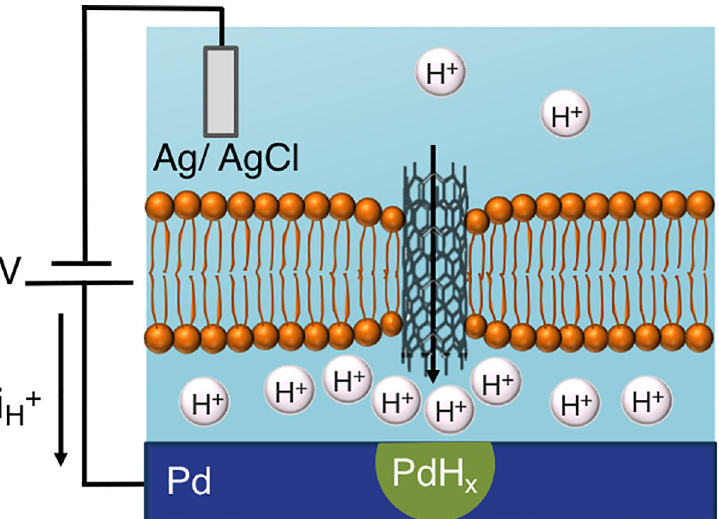
Fig 1. A bioprotonic device with integrated carbon nanotube porins (CNTPs) supports proton current across the SLB through the CNTPs when a negative voltage ( -V ) is applied on the Pd contact. When H + reach the surface